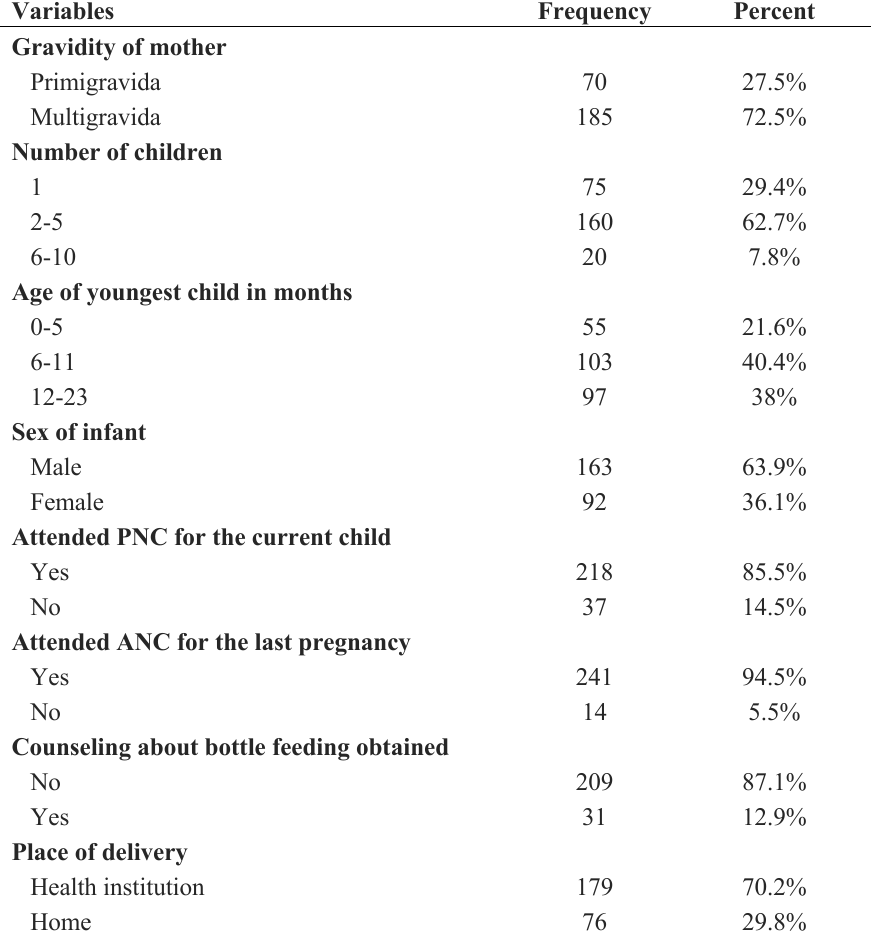
Table 2. Obstetric related factors of mothers with infants less than 24 months of age in Woldia General Hospital, Ethiopia, 2019